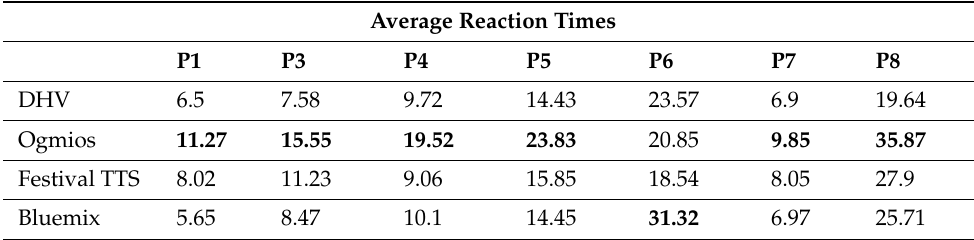
Table 2. Patients’ average RTs per TTS system (system-level). Bold values are the longest RTs of each PWA. RTs are reported in